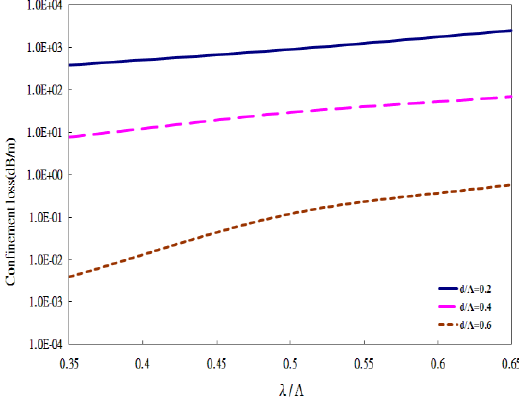
Figure 8. Loss spectra of different air-hole sizes for a PCF having 3 rings (36 air-holes).